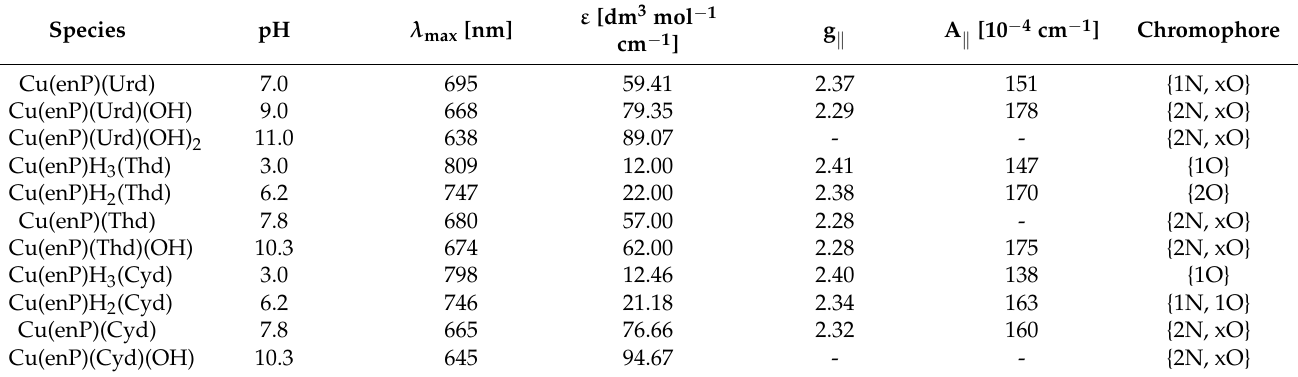
The results of the Vis and EPR studies ( λ max = 695 nm, g (cid:107) = 2.37 and A (cid:107) = 151 × 10 − 4 cm − 1 ) indicate the formation of the species with {N, xO} chromophore (Table 8). The changes in the chemical shifts in the 13 C NMR spectrum of the carbon atoms of uridine C(2) ( − 0.20 ppm) and C(4) (+0.07 ppm) point to the involvement of the N(3) nitrogen atom of uridine in coordination (Table 9). Table 8. Spectral parameters for complexes formed in the ternary Cu(II)/enP/Nuc systems. Species